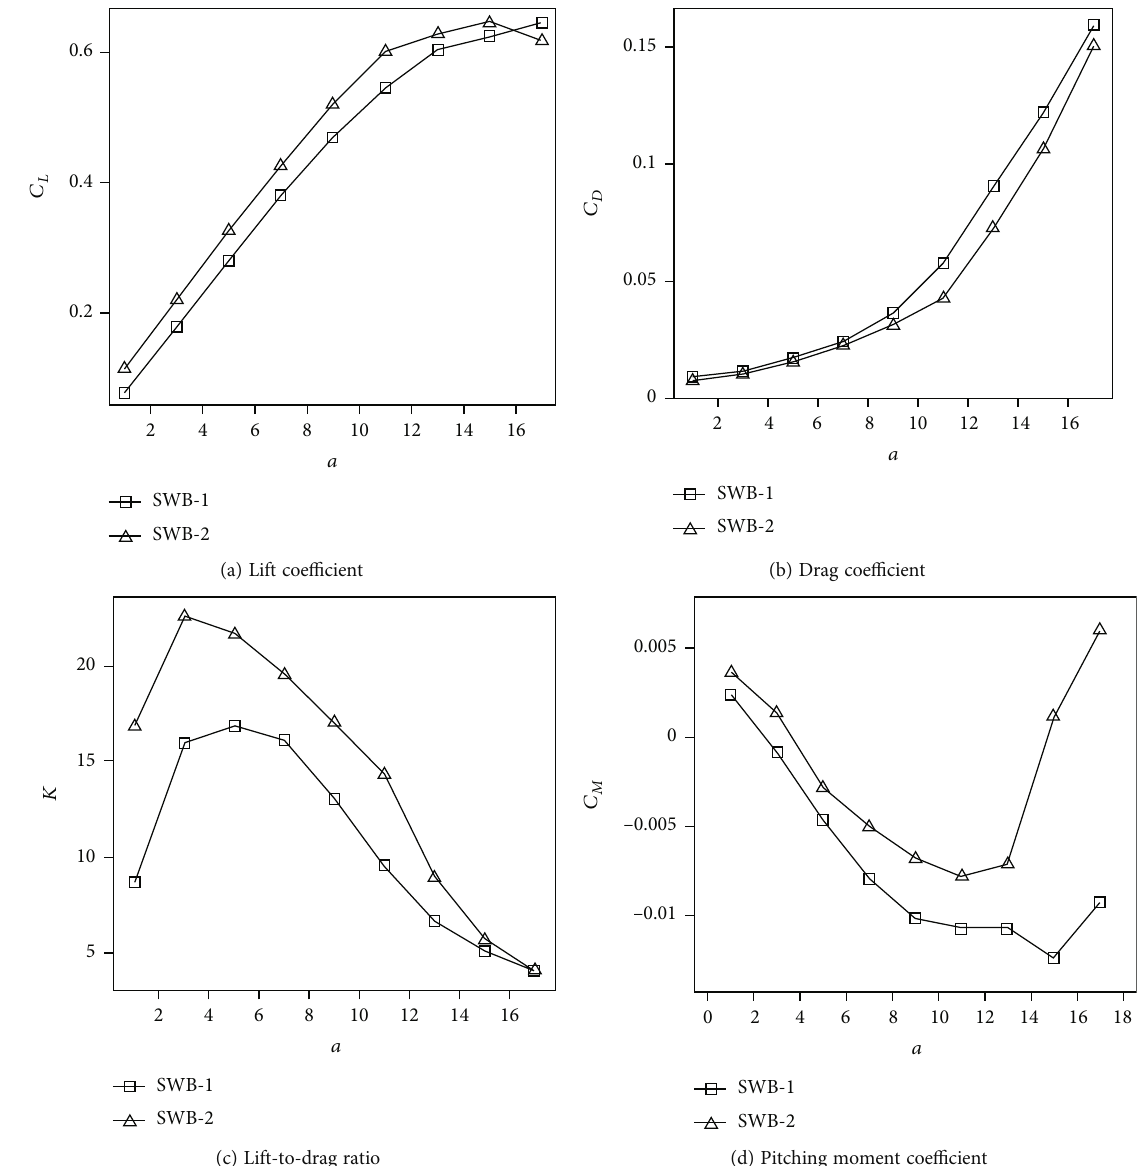
Figure 16: Take-o ff speed aerodynamic performance compared with SWB-1 and SWB-2.